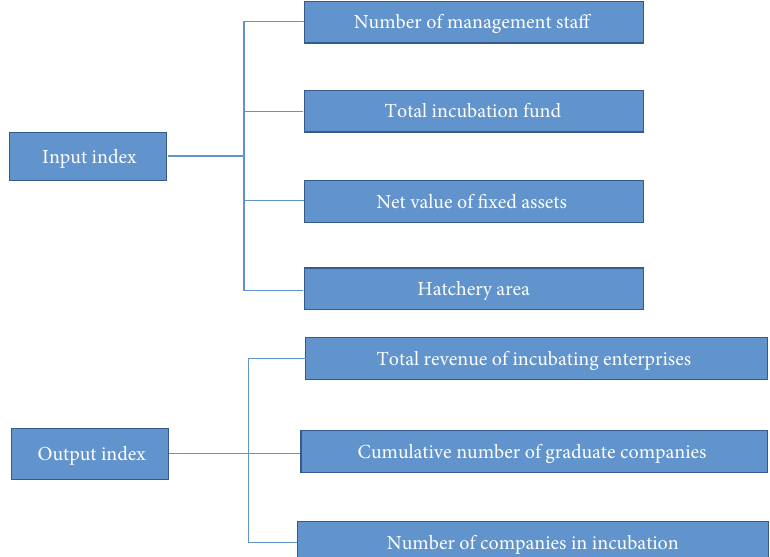
Figure 2: Input-output indicator